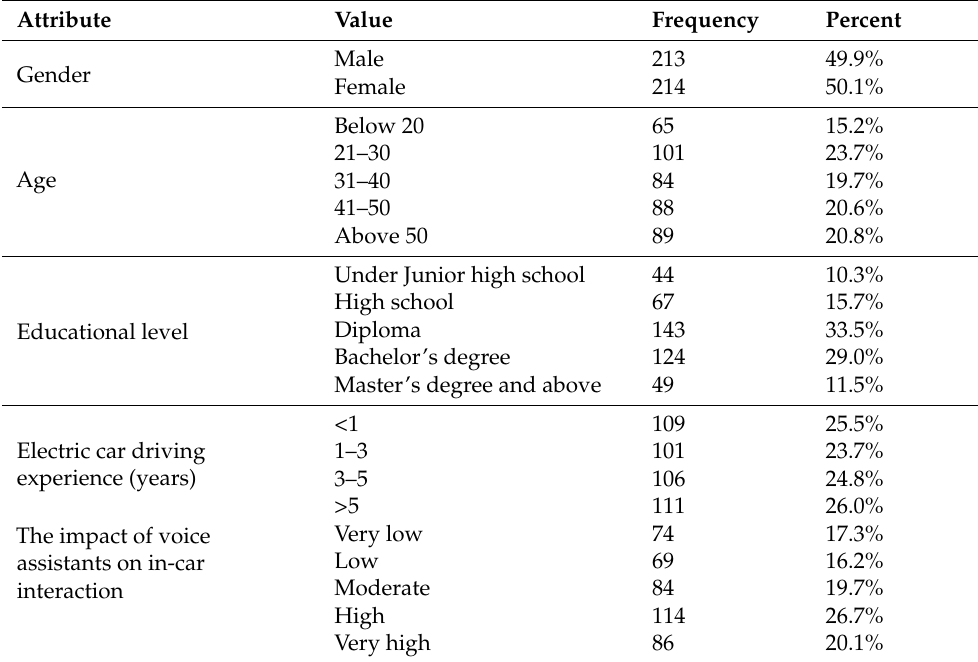
Table 2. Demographic information and partial contents of the questionnaire